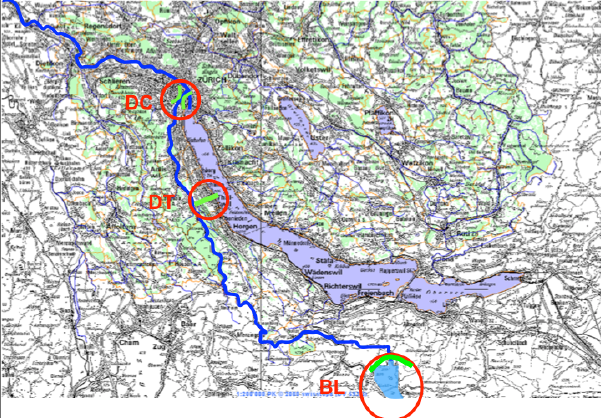
Fig. 2. The Sihl River basin and the locations of the three basic approaches for flood prevention of the Sihl: DC = extension of the discharge capacity of the Sihl Channel in Zürich; DT = discharge tunnel in the Zürich Lake; BL: lowering of the Sihl Barrier